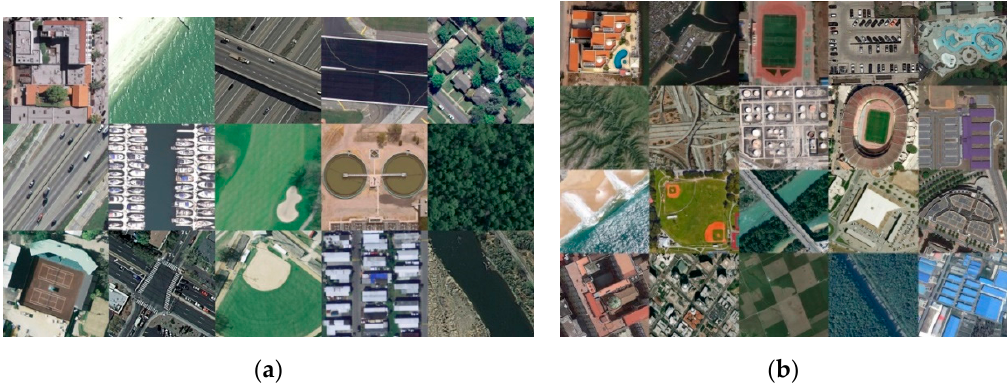
Figure 8. RS images selected from ( a ) the UC Merced Land Use Dataset and ( b ) the Aerial Image Dataset are used for algorithm performance testing.